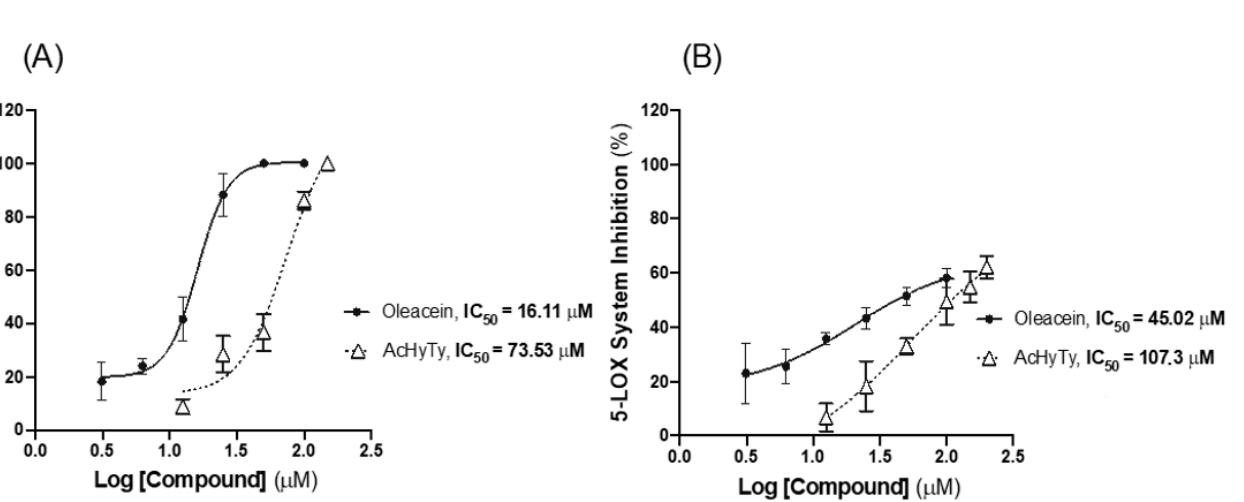
Figure 5. Inhibitory activity of oleacein and AcHyTy on the PLA2 + 5-LOX coupled system ( A ) and 5-LOX pure enzyme ( B ). Results are expressed as the mean ± SEM of four independent assays, each performed in duplicate.